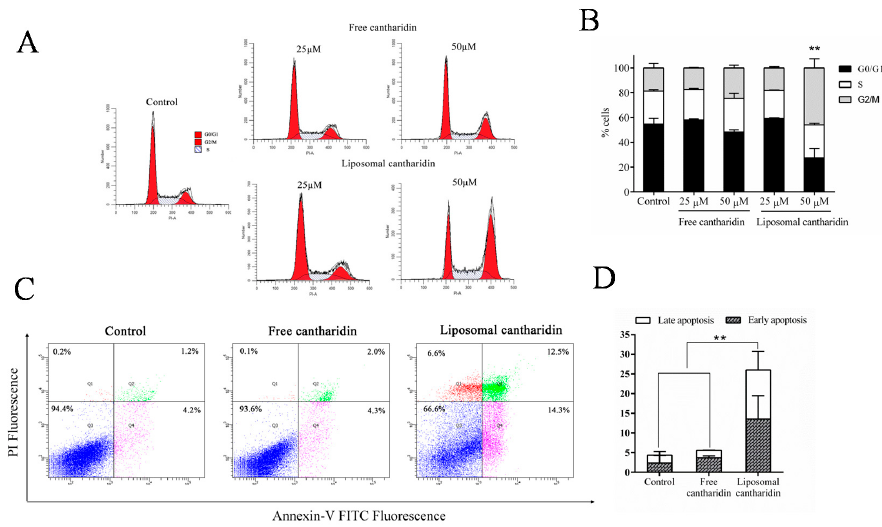
Figure 4. ( A ) Effects of cantharidin and liposomal cantharidin on cell-cycle distribution in HepG2 cells. HepG2 cells were treated with different concentrations of cantharidin and liposomal cantharidin for 24 h and stained with PI. Cellular DNA contents were monitored by flow cytometry. The cell cycle profiles of HepG2 cells under different treatment. ( B ) The percentages of each cell cycle are presented as the mean ± SD of three independent experiments. ** p < 0.01 vs. the control. ( C ) Analysis of apoptotic cell death by flow cytometry. HepG2 cells were treated with PBS, 50 µ M of free cantharidin, and liposomal cantharidin for 24 h. The apoptotic cell death of HepG2 cells was analyzed with an Annexin V–FITC apoptosis detection kit by flow cytometry. ( D ) The quantitative data for later apoptotic cells (Q2 (Annexin V+ and PI+)) and early apoptotic cells (Q4 (Annexin V+ and PI-)) obtained by flow cytometry ( n = 3, mean ± SD). ** p < 0.01 vs. the control and free